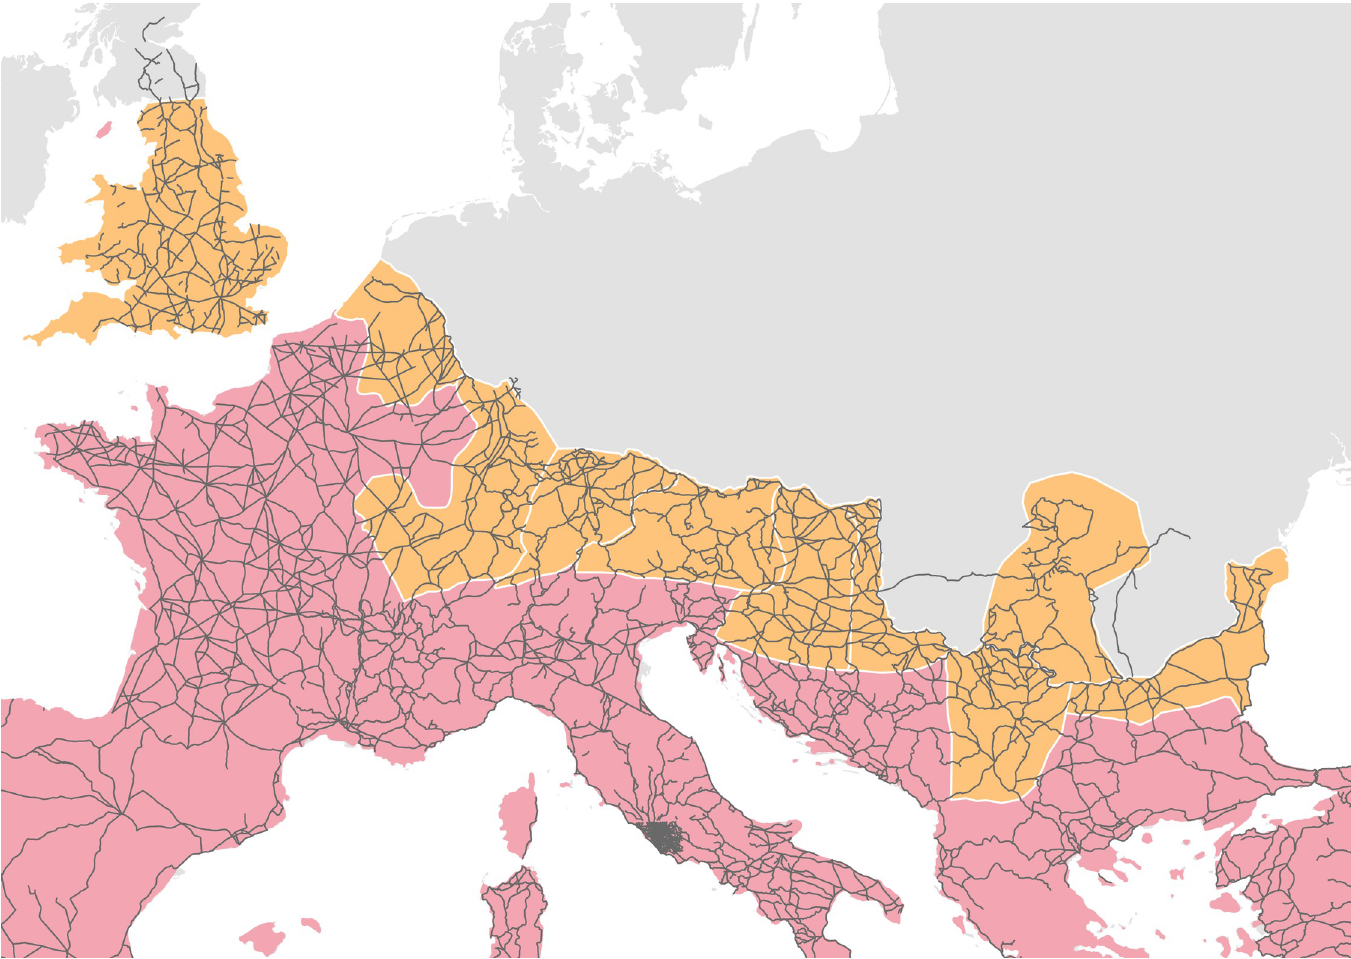
Fig 2. Transportation network of Roman roads. Sources: Natural Earth [31]; Ancient World Mapping Center (AWMC) [32]—Reprinted from AWMC database of shapefiles [32] under a CC BY license, with permission from AWMC, original copyright 2012.